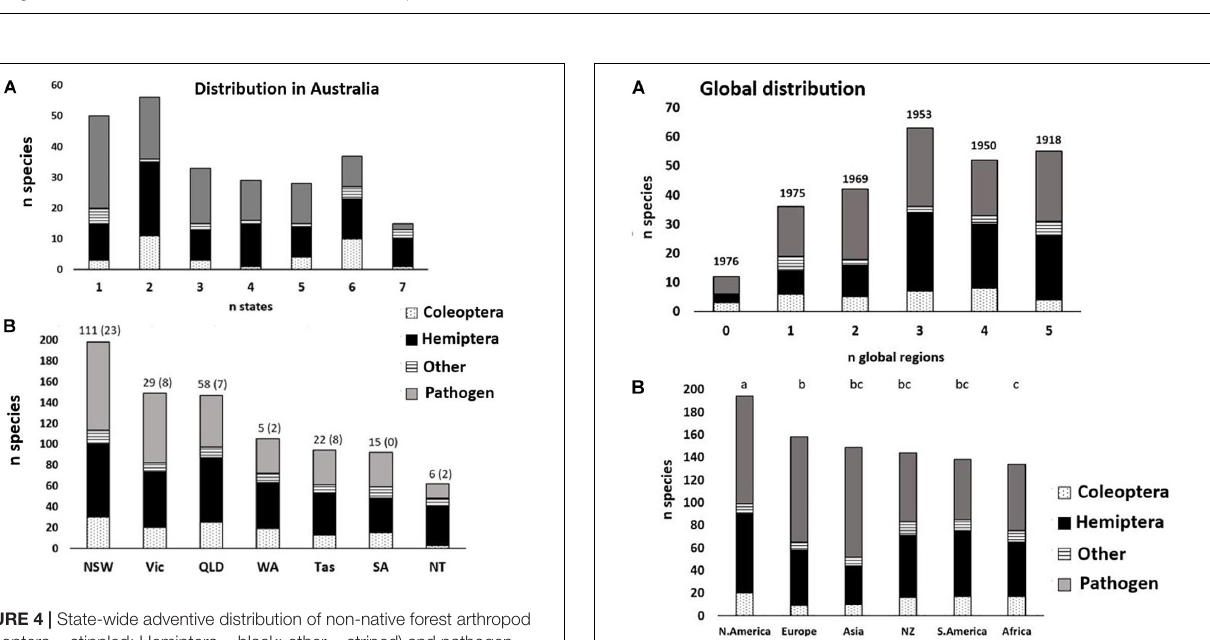
FIGURE 3 | Non-native species established in each Australian state by first record status. Species’ first Australian establishment is designated according to native range: Asia (light gray), Europe (black), North America (white), South America (dark gray), and unknown/other origin (stippled). Species that established in each state following a first establishment elsewhere in Australia are striped.